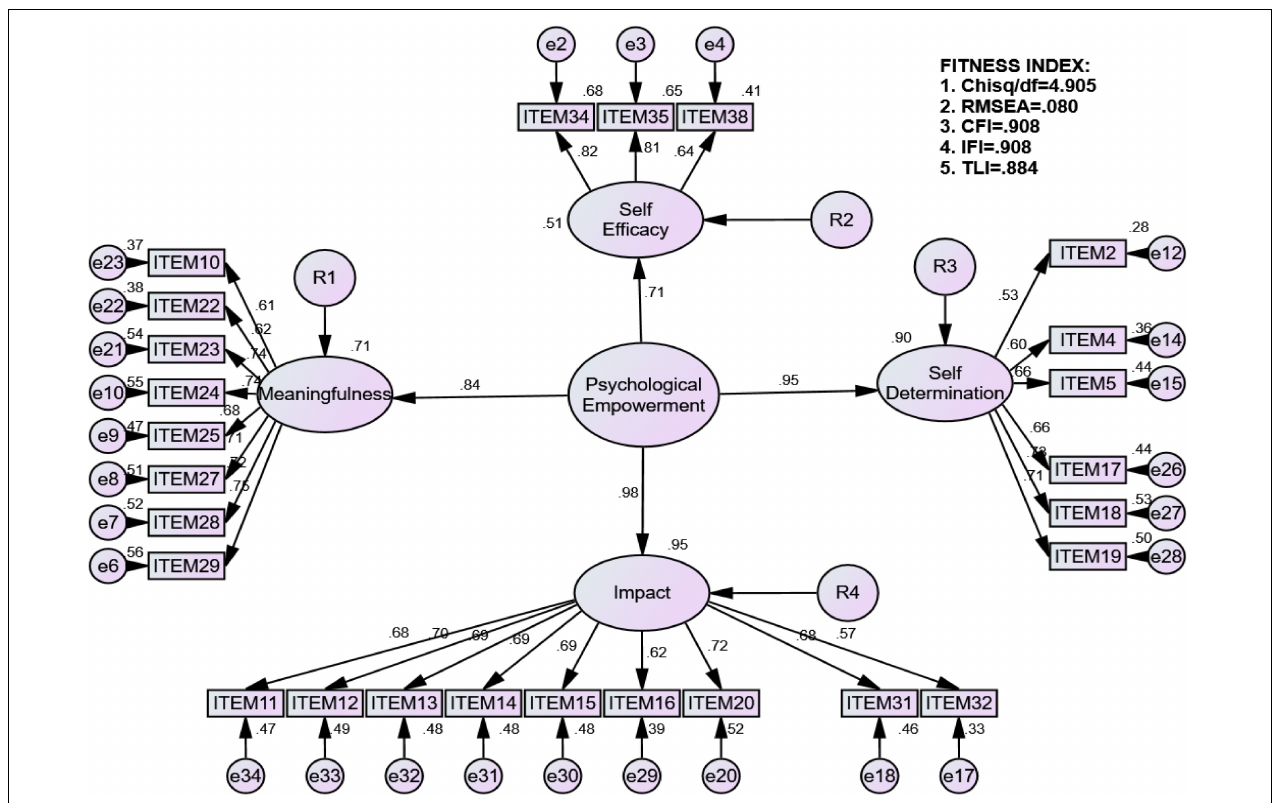
FIGURE 1 | Exploratory construction of Multicultural Psychological Empowerment Scale for Saudi Women. TABLE 7 | Correlation coefficients between the degree of each item and the degree of the dimension to which it belongs and the total score of the scale. Items Correlation coefficient with Correlation coefficient with Correlation coefficient with Correlation coefficient with Dimension Total degree Dimension Total degree Dimension Total degree Dimension Total degree Meaningfulness Impact Self-efficacy